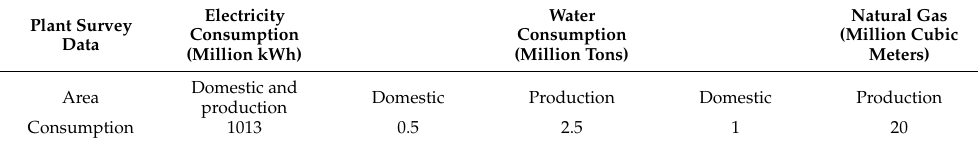
Table 7. Factory survey data sheet.